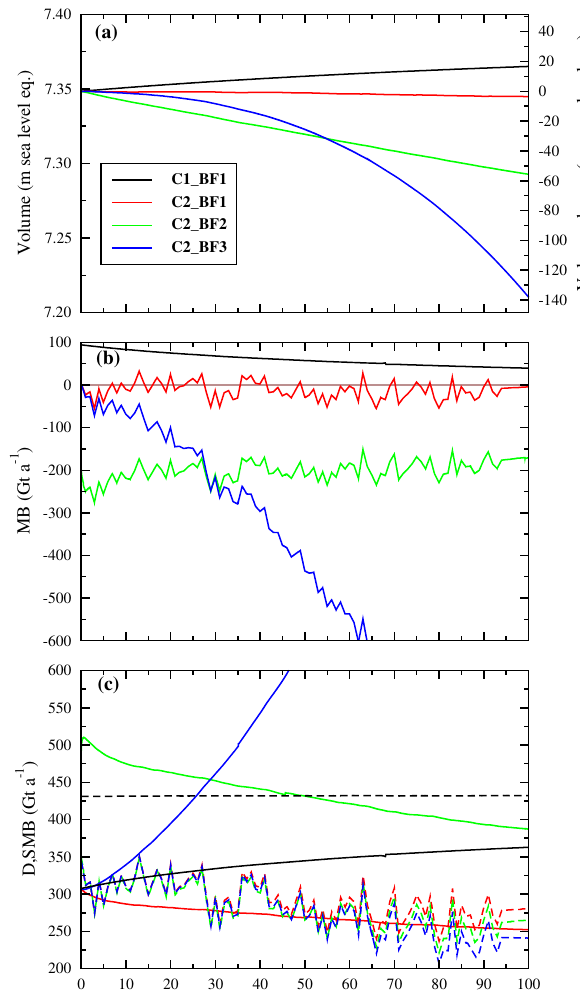
Fig. 8. GrIS future mass balance as a function of time: (a) total ice volume (left axis, meters of sea level equivalent) or volume change from initial time (right axis, milimeters of sea level equivalent), (b) annual mass balance (the brown line correspond to 0) and (c) dis- charge ( D ) (solid lines) and SMB (dashed lines) in Gta − 1